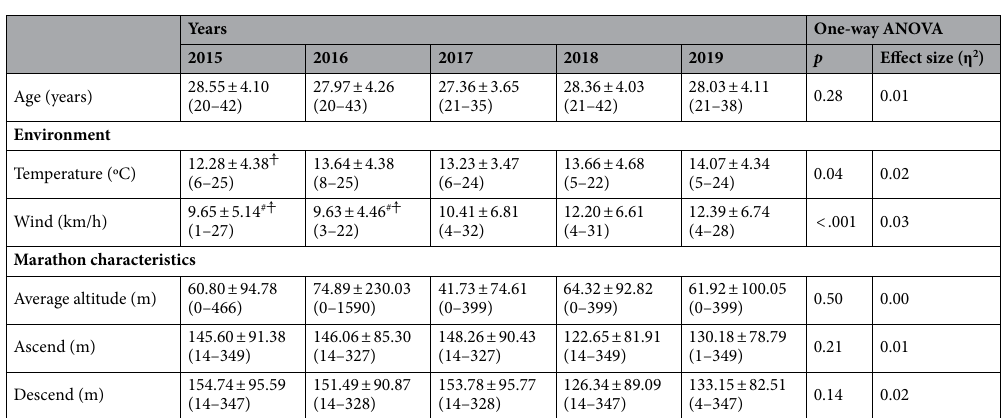
Table 1. Results of the age, environment and marathon characteristics across the years analyzed. Data are presented as mean ± standard deviation and range (minimum–maximum). Post hoc analysis: # Different from 2018 (p < 0.05); ⍏ Different from 2019 (p <